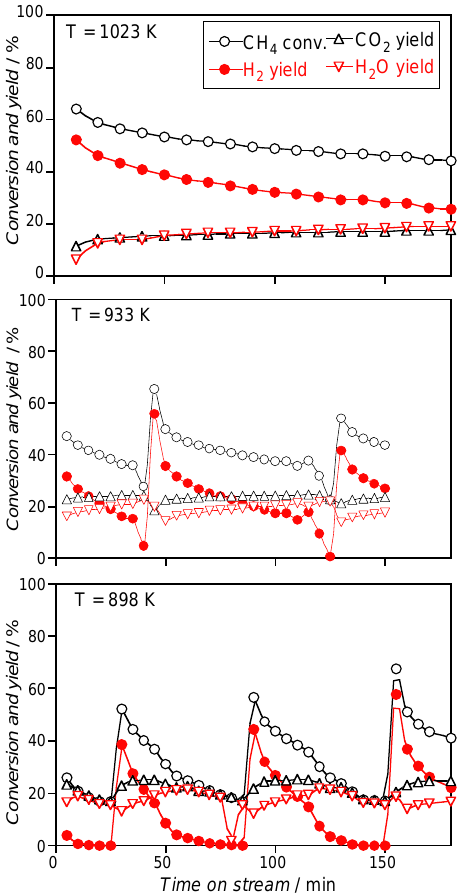
Figure 14. CH 4 conversion and H 2 , CO 2 and H 2 O yields on 5.1Ni/Z m ( red ) catalyst as a function of time on stream for specific temperatures. Reactant mixture: [CH 4 ] = 2%, [O 2 ] = 1%, N 2 as balance; total flow rate = 150 cm 3 (STP)·min −1 .